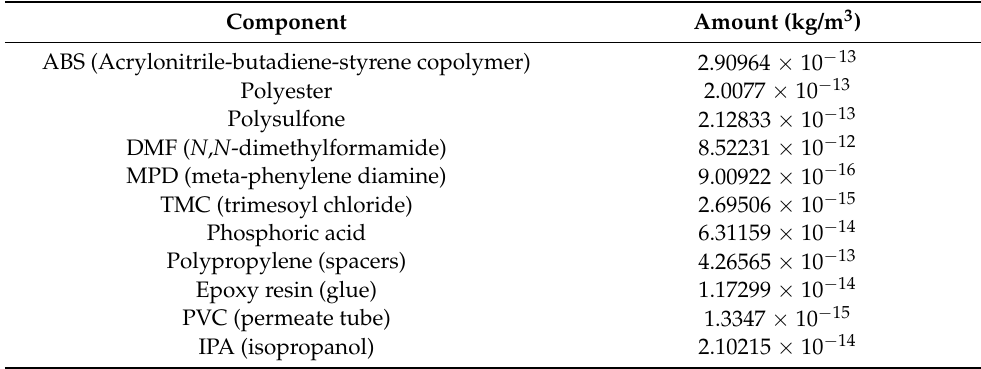
Table 4. Materials usage in fabrication of RO modules for their